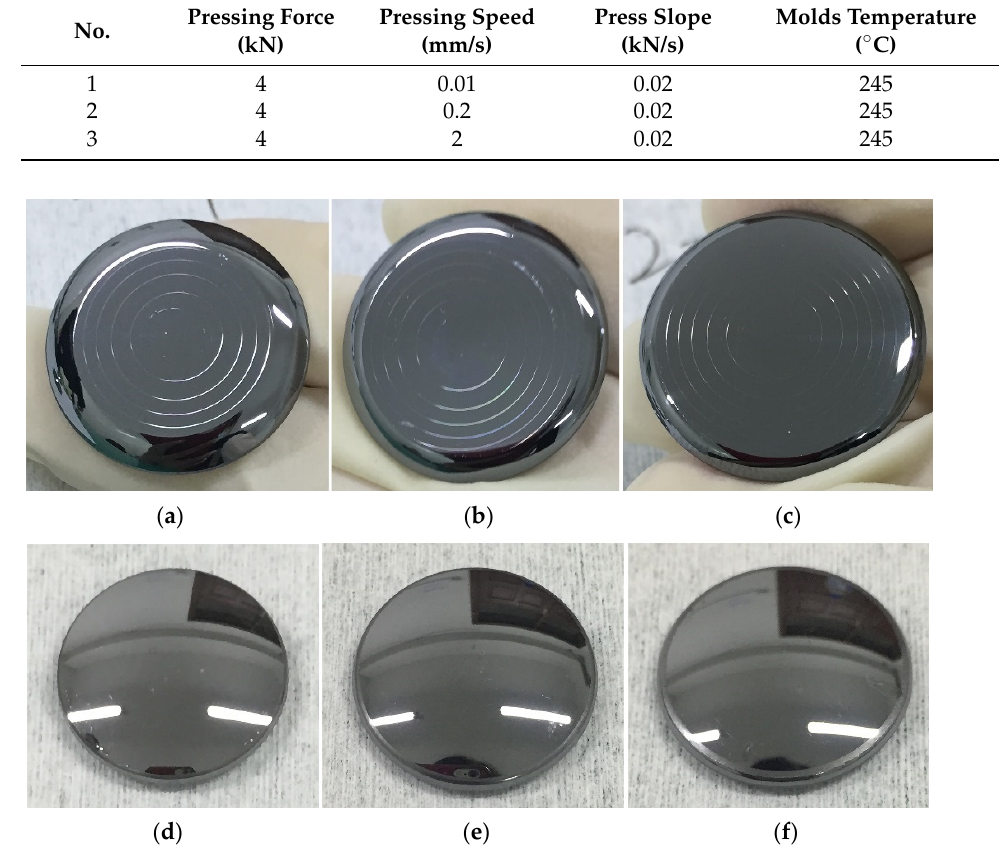
Figure 3. Photographs of diffractive surfaces and the aspherical surfaces of the molded lens: ( a , d ) the lens surfaces in the No.1 experiment; ( b , e ) the lens surfaces in the No.2 experiment; ( c , f ) the lens surfaces in the No.3 experiment.